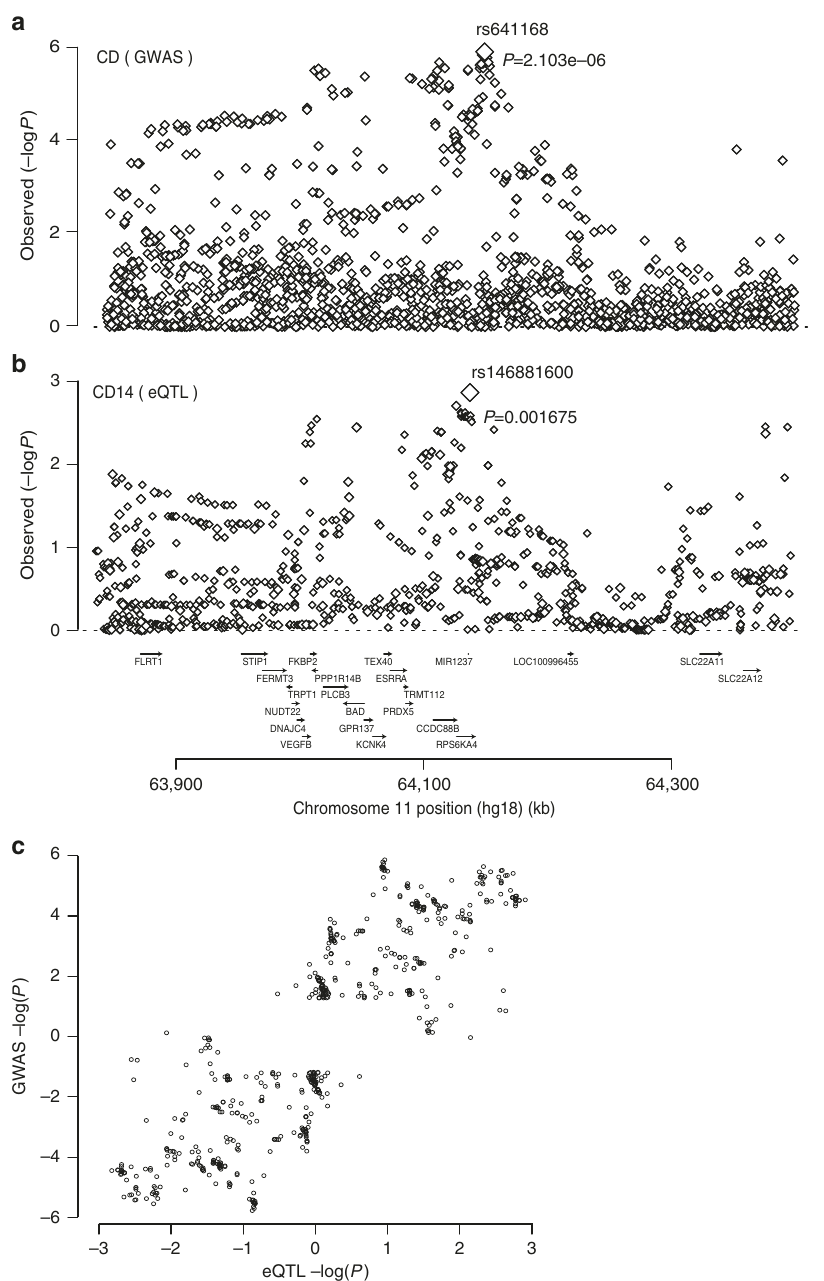
Fig. 5 CD risk is positively associated with expression of CCDC88B in CD14 + cells. a Genetic association between CD and SNPs in a 600Kb window on 11q13. Log(1/ p ) values are given for all SNPs positioned on the human hg18 build 1 . The association signal was maximal for rs641168 ( P = 2.1 × 10 -6 , using a logistic regression analysis). Gene names and positions are shown under the graph. b eQTL association pattern for C CDC88B expression in CD14 + cells for the same chromosome region as in a . The association signal was maximal for rs146881600 ( P = 0.0017, using a logistic regression analysis). c Correlation between the disease and eQTL association patterns. Two data points are shown for each “ informative ” SNP (i.e., with data in both analyses and log(1/ p ) value ≥ 1.2 with either disease, eQTL or both). One corresponds to log(1/ p ) values (disease and eQTL) multiplied by the signs of the effects of allele 1, the other with the log(1/ p ) values multiplied by the signs of the effects of allele 2. The observed correlate was shown to be signi fi cant ( P = 0.01, by a logistic regression analysis) using the approach described in the Methods